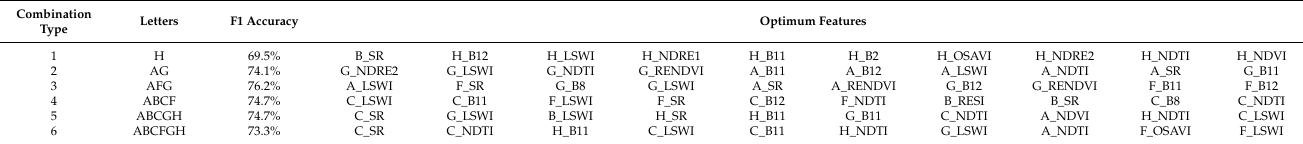
Table A10. Top-10 optimal soybeans feature sets for different combination types on 28 May 2020.